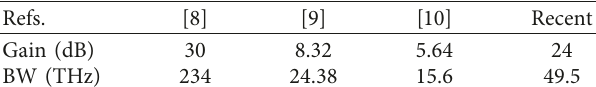
Table 2: Comparison with previous results.